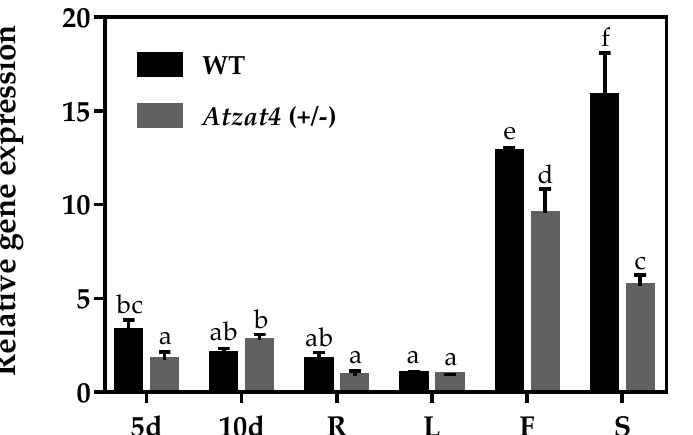
Figure 4. Gene expression profile of Atzat4 (+/ − ) in vegetative and reproductive tissues of Arabidopsis